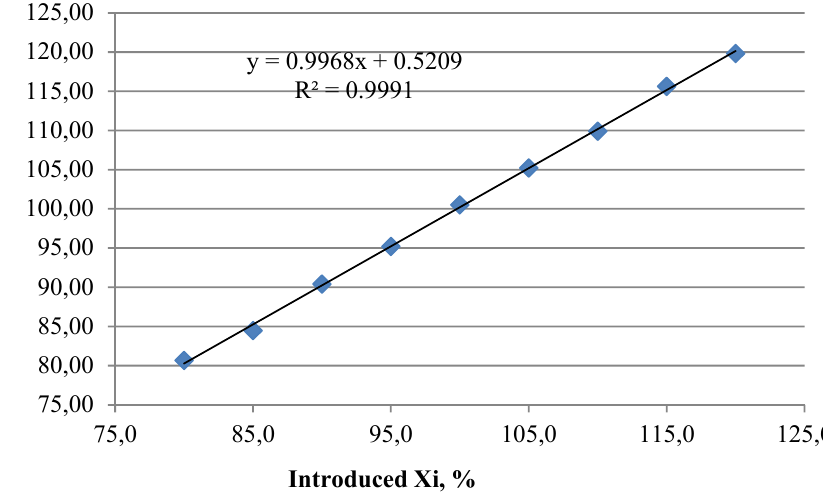
Fig. 5. Linear dependence graph for